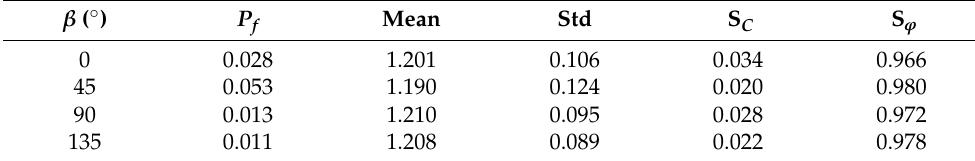
Table 4. Probabilistic results comparison with different values of random field rotation